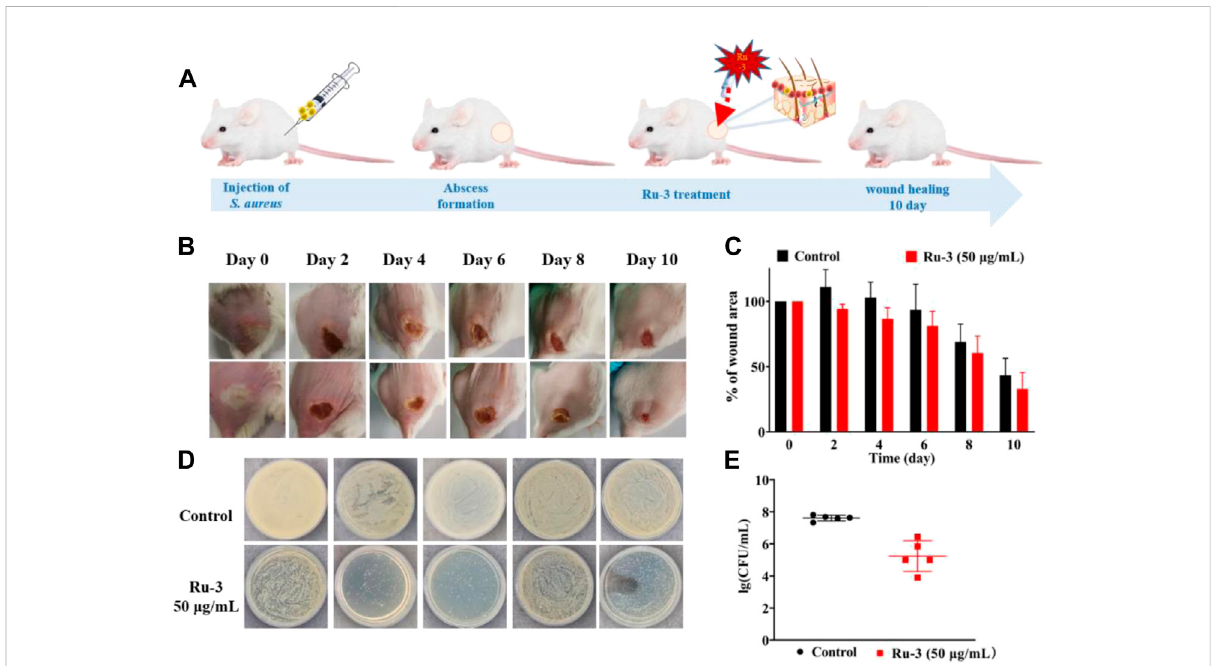
FIGURE 16 Treatment of Staphylococcus aureus skin infection in vivo (A) Scheme illustration of the procedures including the establishment of the Staphylococcus aureus infection mouse model and subsequent treatment regime. (B) Representative photos of skin abscesses with/without